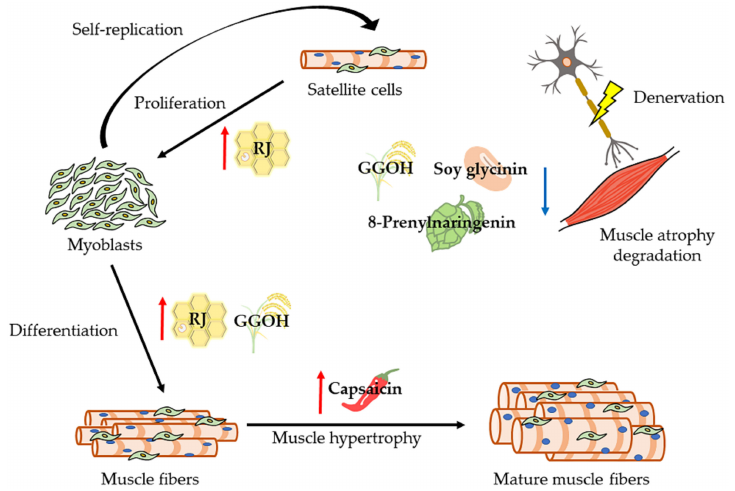
Figure 3. Schematic overview of the effective natural compounds in muscle remodeling